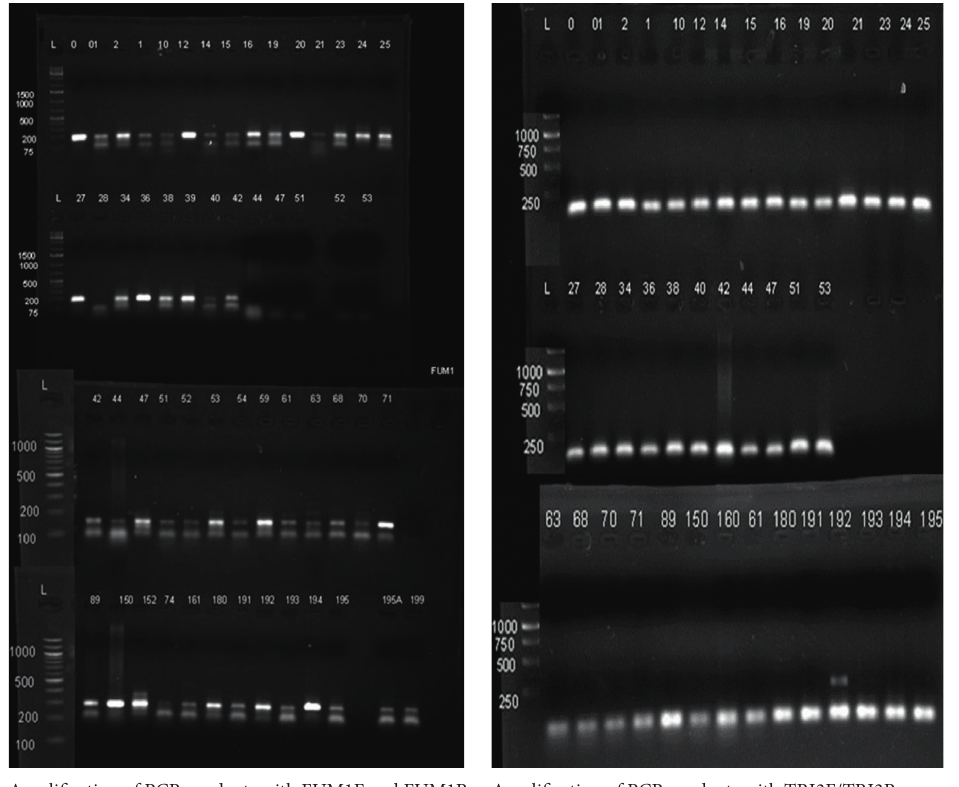
Figure 3: Agarose 1% gels electrophoresis showing PCR products for tests on toxigenic potential of Fusarium spp. isolates based on FUM1F/ FUM1R (183bp) and Tri13F/Tri13DONR (282 bp) base pairs. (a) Amplification of PCR products with FUM1F and FUM1R primer pairs specific to production of fumonisins. (b) Amplification of PCR products with TRI3F/TRI3R primer pairs specific to production of deoxynivalenol.